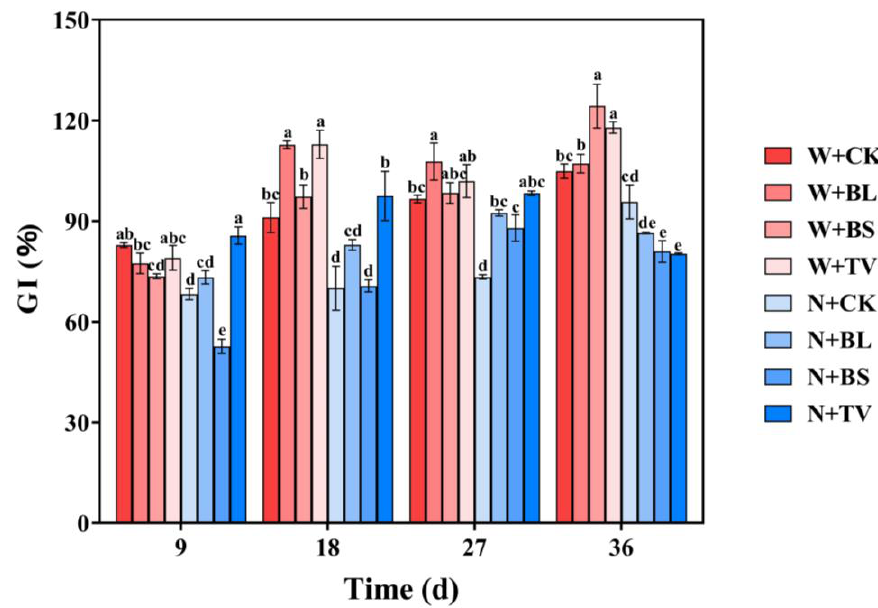
Figure 9. Changes in seed germination index (GI) in the treatments. Means ± SEs with different letters in each parameter indicate significant statistical differences ( p < 0.05).